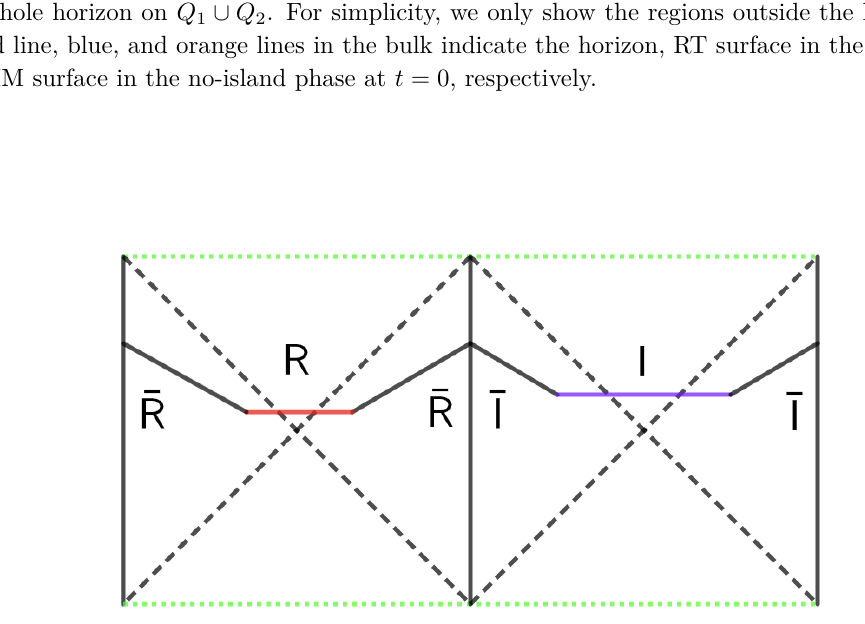
Figure 8 . Penrose diagram on the branes for case I: one two-side black hole approximately. The left and right vertical lines are glued together. The black-dotted, green-dotted, red, and purple lines denote the horizon, singularity, radiation region, and island region, respectively. The black lines linking R and I represent ¯ R ∪ ¯